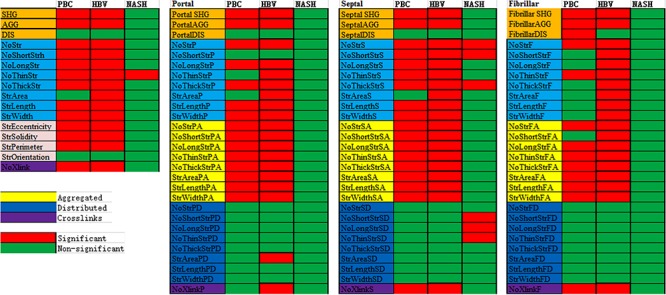
Spearman correlation analysis of parameters in portal, septal and fibrillar areas with stages for chronic hepatitis B (CHB), primary biliary cirrhosis (PBC) and non-alcoholic steatohepatitis (NASH). Orange, light blue and gray colors are used for differentiation of different parameters. SHG, second harmonic generation; AGG, aggregated collagen percentage; DIS, distributed collagen percentage. See Supplementary Table S1 for details.